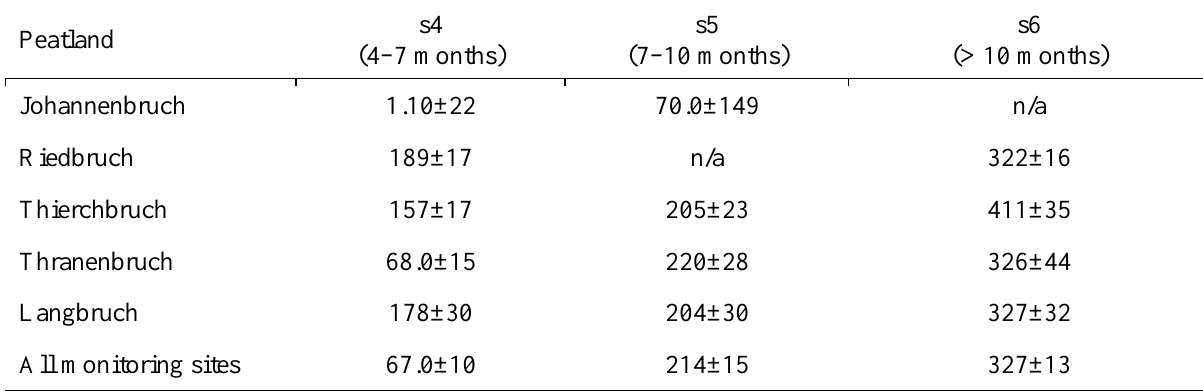
Table 2. Weighted mean (± SE) carbon stocks (t ha -1 ) of waterlogging stages (s4, s5, s6) of the soils at monitoring sites. S4 corresponds to 4 to 7 months of waterlogging conditions in the upper soil, s5 7 to 10 months and s6 more than 10